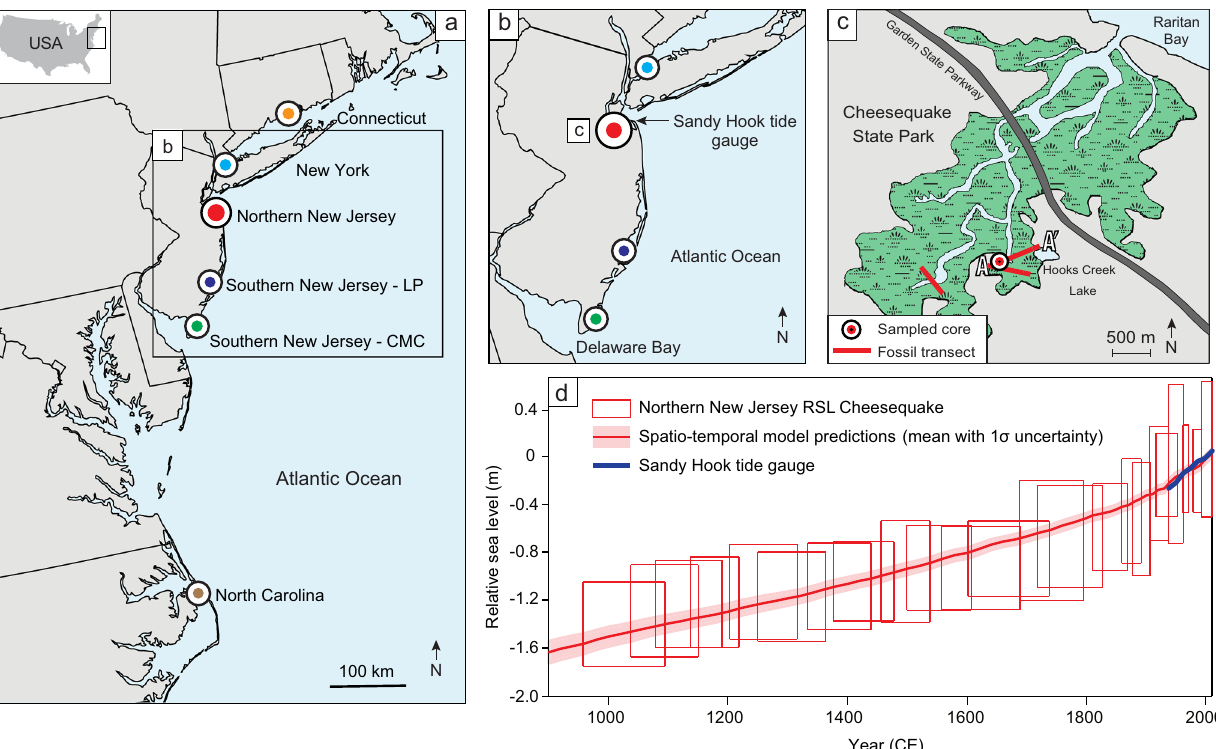
Fig. 1 Location of relative sea-level (RSL) reconstructions on the U.S. Atlantic coast. a The six sites used in analysis from north to south are: Connecticut 60 , New York City 15 , northern New Jersey (this study), southern New Jersey (Leeds Point (LP) and Cape May Courthouse (CMC) 14 ), and North Carolina 45 . b Map of New Jersey with location of new northern New Jersey record and Sandy Hook tide gauge. c Salt-marsh study site at Cheesequake State Park in northern New Jersey off of Raritan Bay where the new RSL record was produced. Fossil core transect locations shown, including location of the sampled core for detailed analysis. d RSL record from northern New Jersey with spatiotemporal model predictions (mean with 1 σ uncertainty) and decadal- average RSL measurements from the Sandy Hook tide gauge. Boxes represent the vertical RSL (1 σ ) and chronological (2 σ ) uncertainty for each data point.